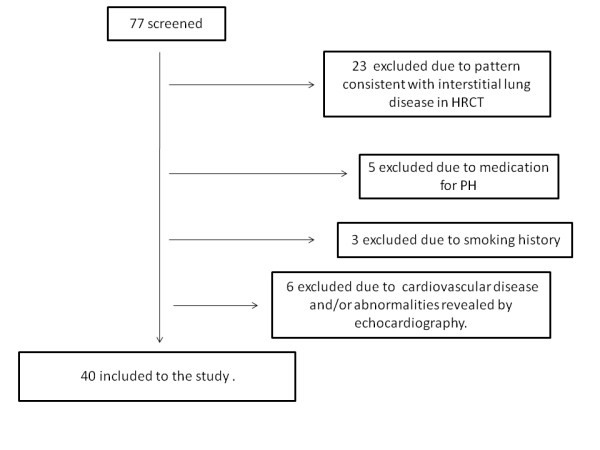
Flow chart of the study participants.